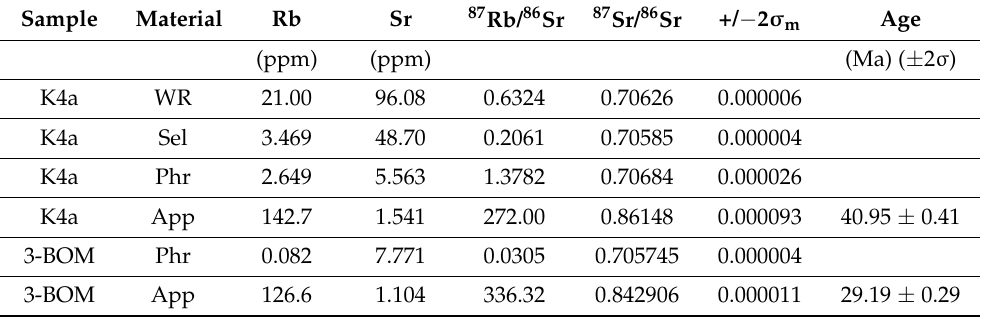
Table 4. Rb-Sr isotopic data on whole rock (WR), selvage (Sel), prehnite (Prh), and apophyllite (App) from the Deccan volcanic province (India) near Mumbai. Rb-Sr ages were calculated assuming an error of ± 1% on the 87 Rb/ 86 Sr